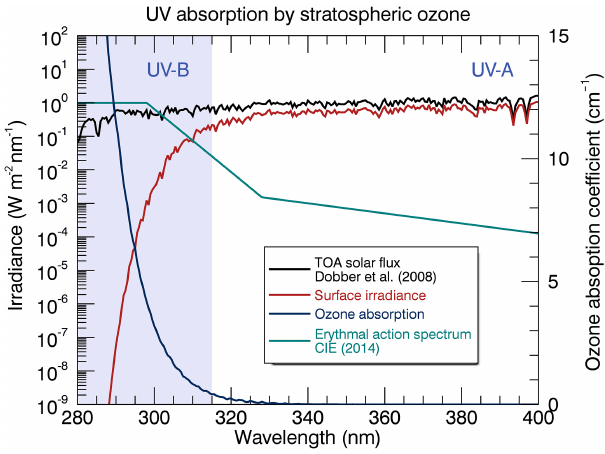
Figure 1. Sample UV irradiance spectrum at the Earth’s surface on a clear summer day (averaged and sampled over 0.5nm intervals). Stratospheric (O 3 ) is the primary species which serves to absorb UV radiation in the atmosphere (blue curve). The Huggins–Hartley band system of O 3 attenuates the radiative flux (black curve) by several orders of magnitude in the UV-B region. The product of the absorption cross section and the top-of-atmosphere flux gives the resultant incoming irradiance at the surface (red curve). The ery- themal action spectrum (green curve) demonstrates the increasing susceptibility of human skin to epidermal damage